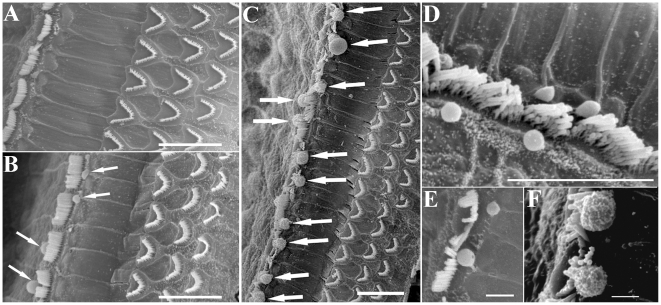
Scanning electron microscopy analyses of CTR (A) and MLCKIKO (B–F) mice.(A) CTR mice show normal hair bundles in one row of IHCs and three rows of OHCs on the basilar membrane (BM). (B–F) In MLCKIKO mice, several ball-like structures were observed around the hair bundles of the IHCs (arrows). Scale bars: 10 µm (A–D) or 2 µm (E–F).